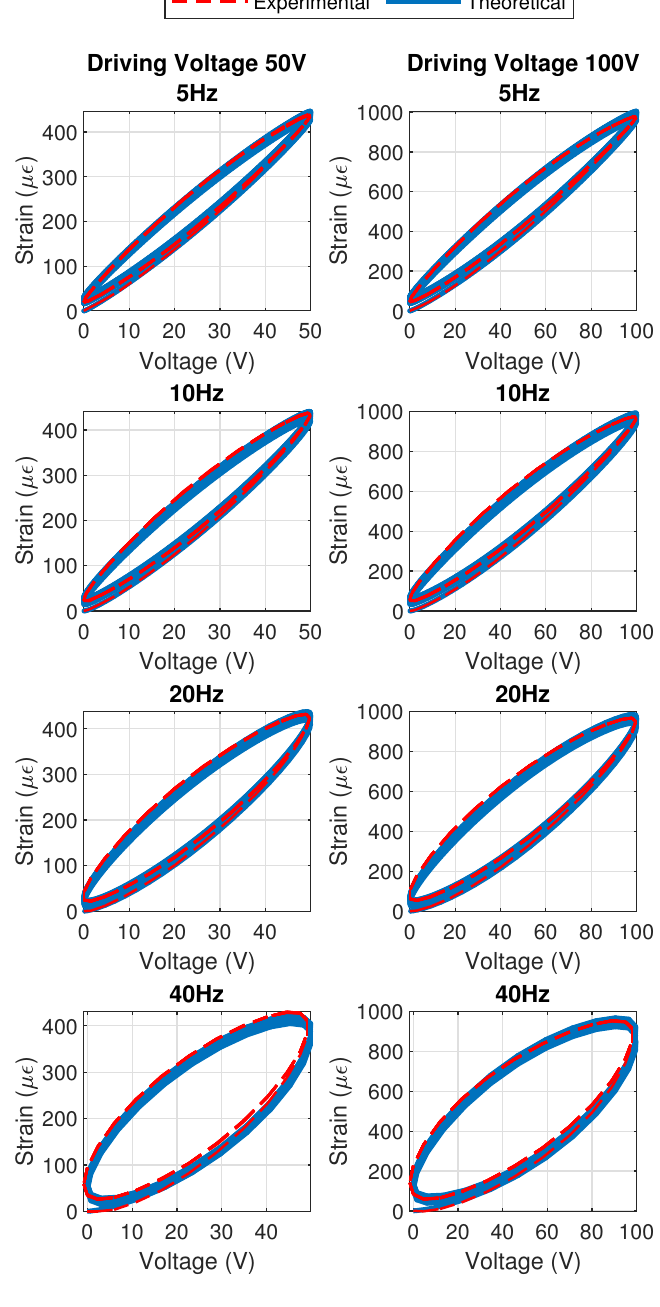
Figure 9. Experimental results and comparison with model predictions under sine excitation for several driving voltage magnitudes and